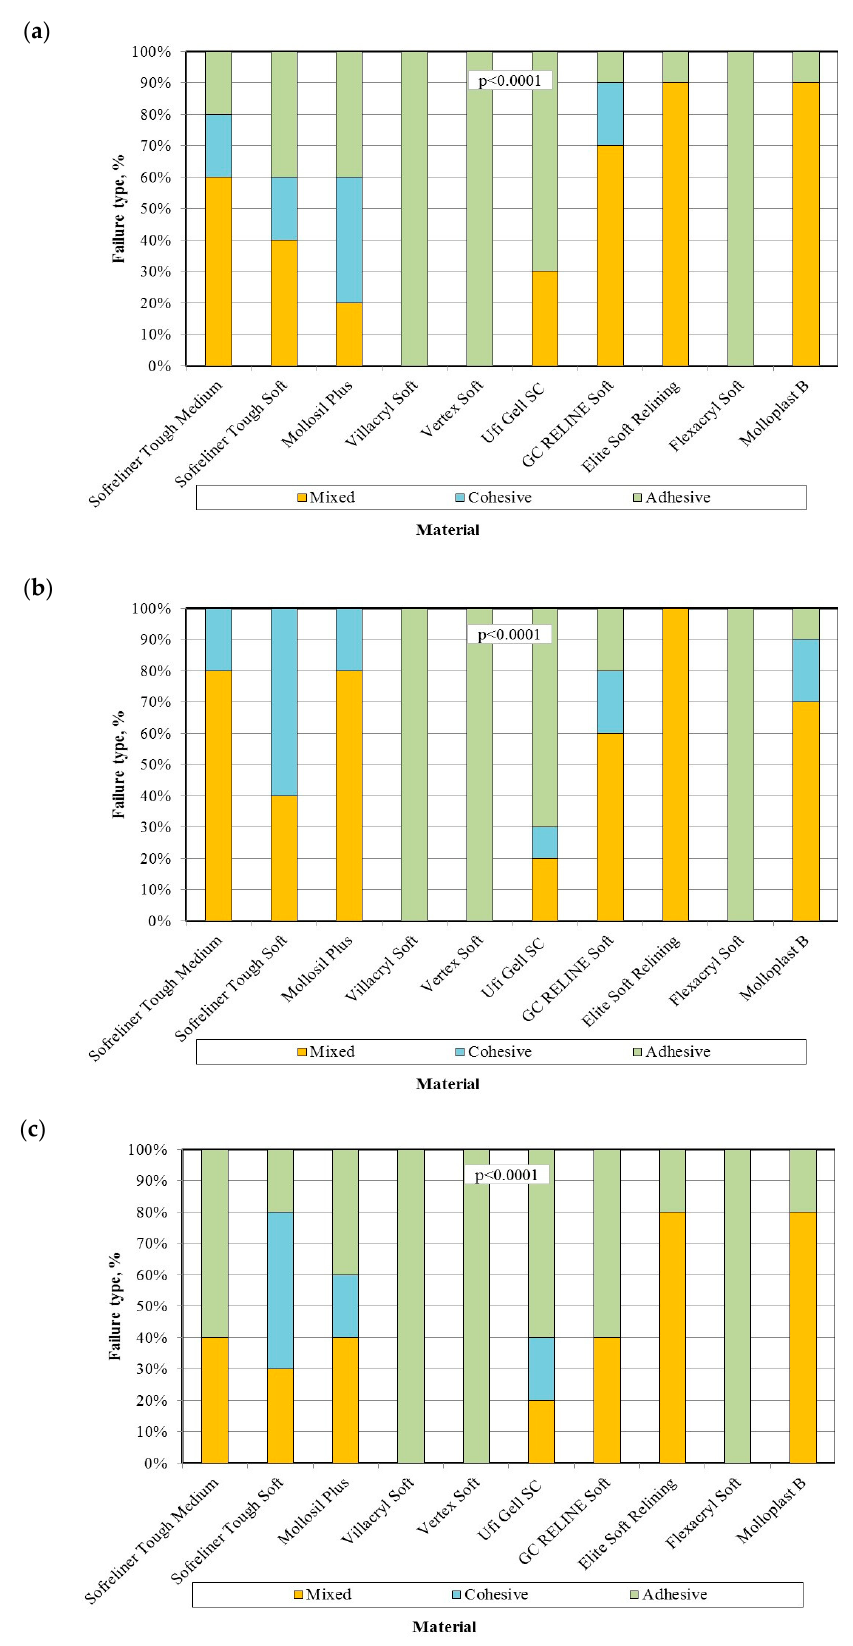
Figure 3. Influence of the lining material on the failure type in tensile strength test after 7 days ( a ), 28 days ( b ), and 90 days ( c ) of conditioning the samples in distilled water, α = 0.05.